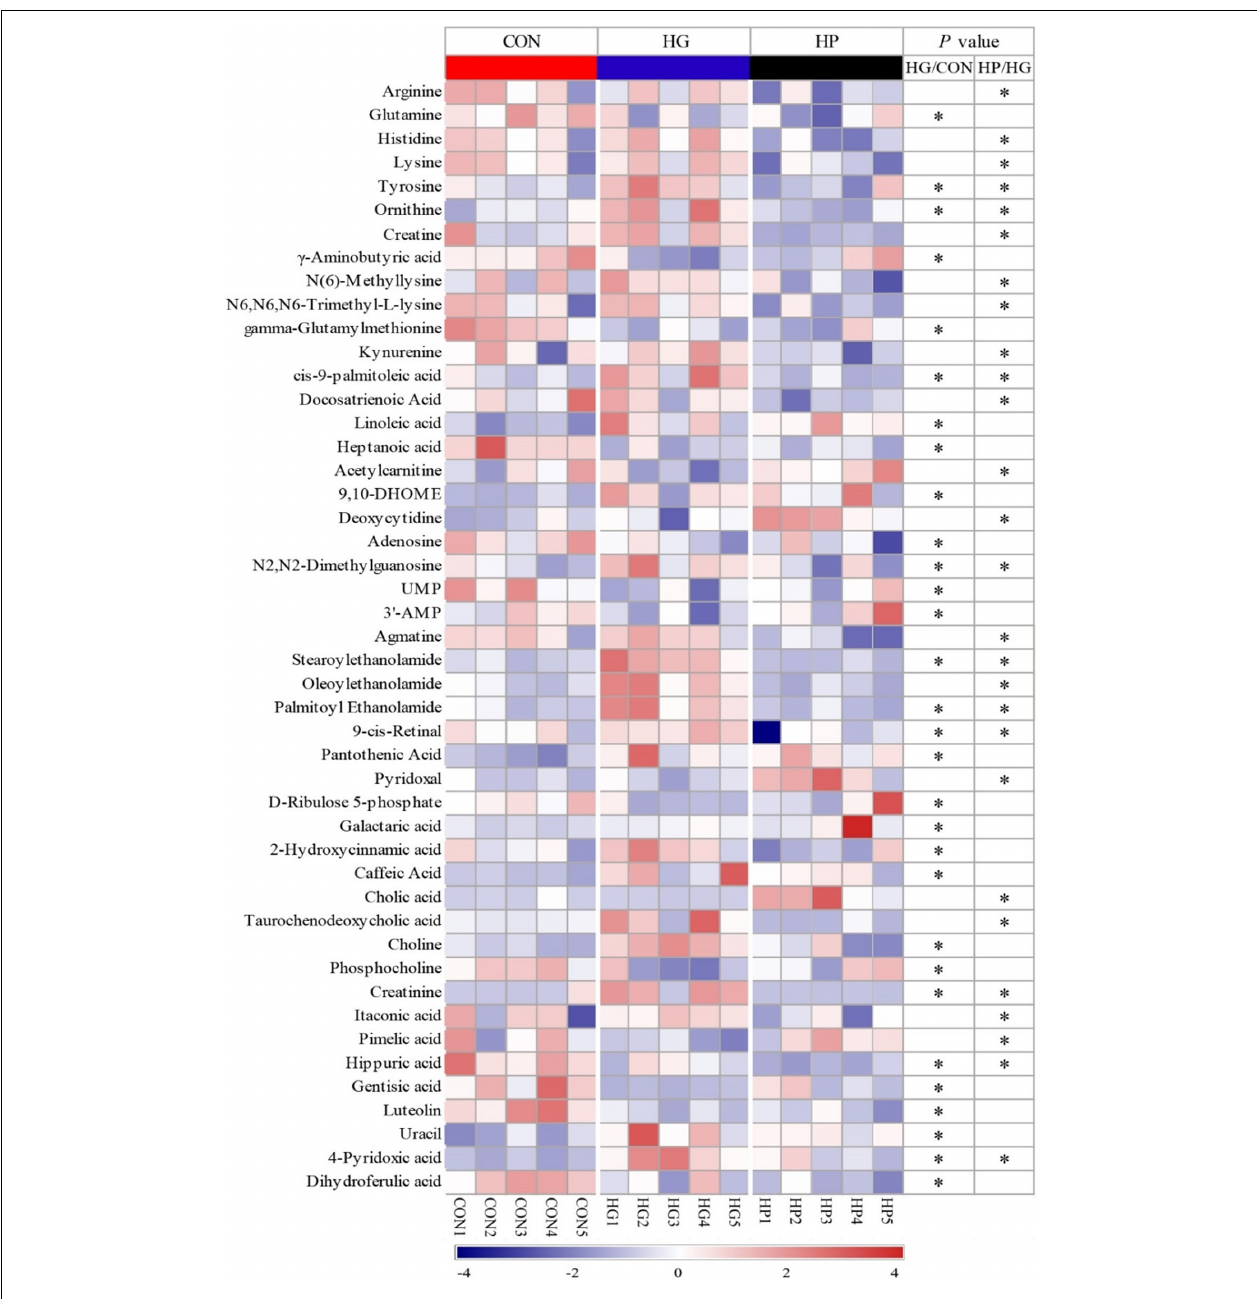
FIGURE 4 | Heat-map visualizing of the differential metabolites identified in the ileal mucosal samples of sheep fed CON, HG, and HP